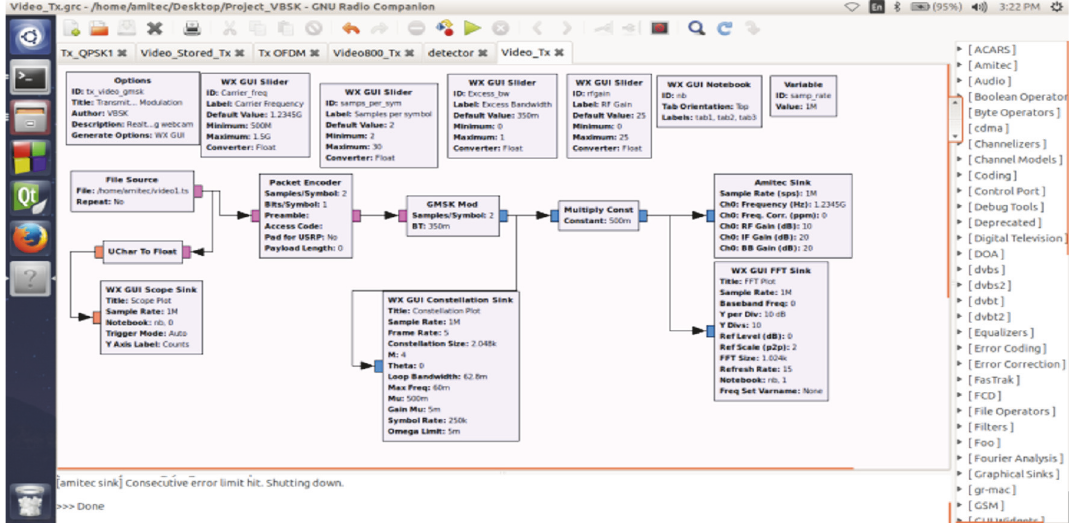
Figure 5: Transmitter flow graph for video transmission designed using GNU radio.